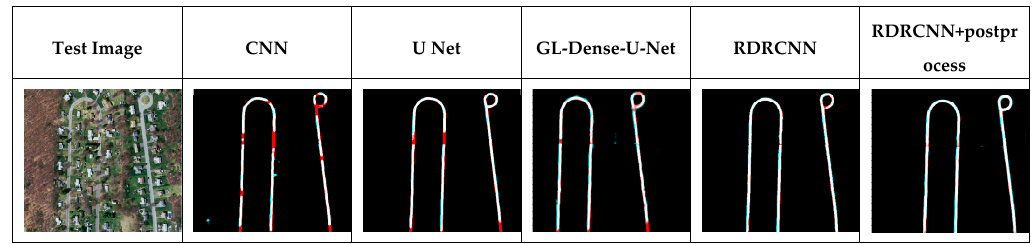
Figure 8. Comparison of the road extraction results of four methods in different experimental areas of the Massachusetts dataset. Zoomed-in view to see more details.